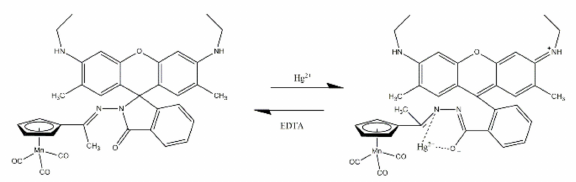
Figure 5. The possible sensing mechanism of the prepared sensor (Table 1, No. 6) to Hg 2+ [38]. Wang Q., et al. synthesized three rhodamine based probes 1, 2, and 3 (Table 1, No. 7) and applied them for Hg 2+ detection in Tris-HCl/C 2 H 5 OH (v:v = 3:7, 10 mM, pH = 7.2). All three probes were colorless at first but turned to visible pink after the addition of Hg 2+ with the fluorescence increment. The detection limits of probes 1, 2, 3 to Hg 2+ were 18 nM, 16 nM, 56 nM, respectively. These probes were successfully applied to both environmental samples and bioimaging applications, as shown in Figure 6.